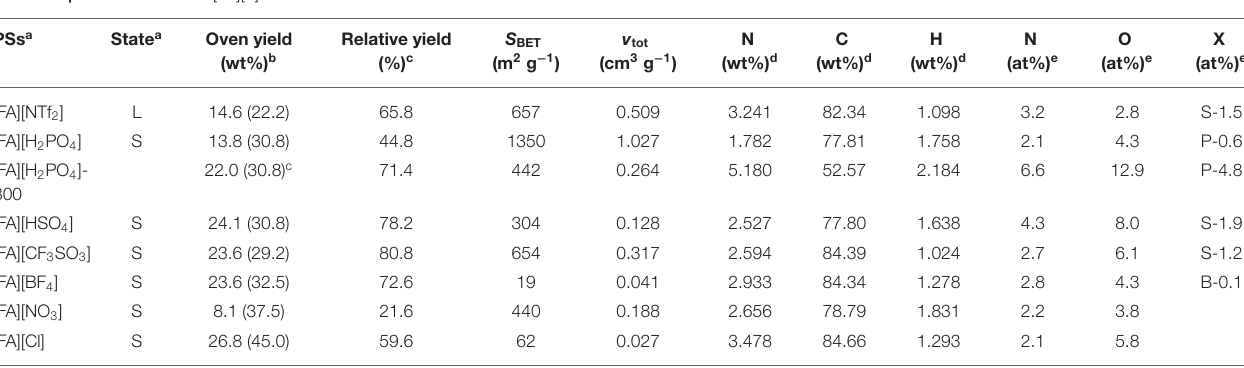
TABLE 1 | Characteristics of [FA][X]-derived